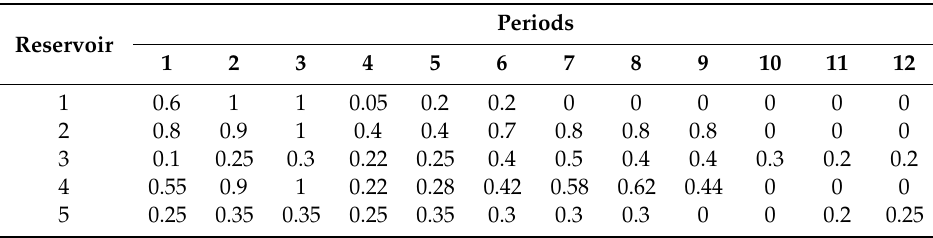
Table 1. The benefit per unit release.